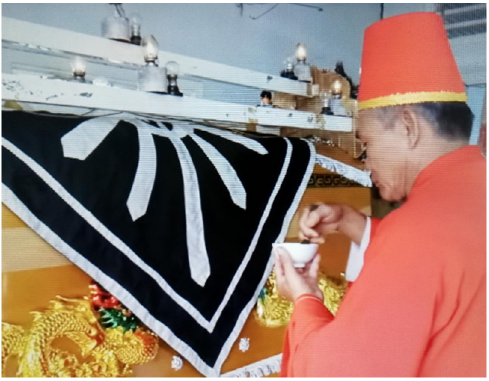
Figure 8. The talismanic ritual of Hành phép xác performed in the deceased’s house by a priest of Tây